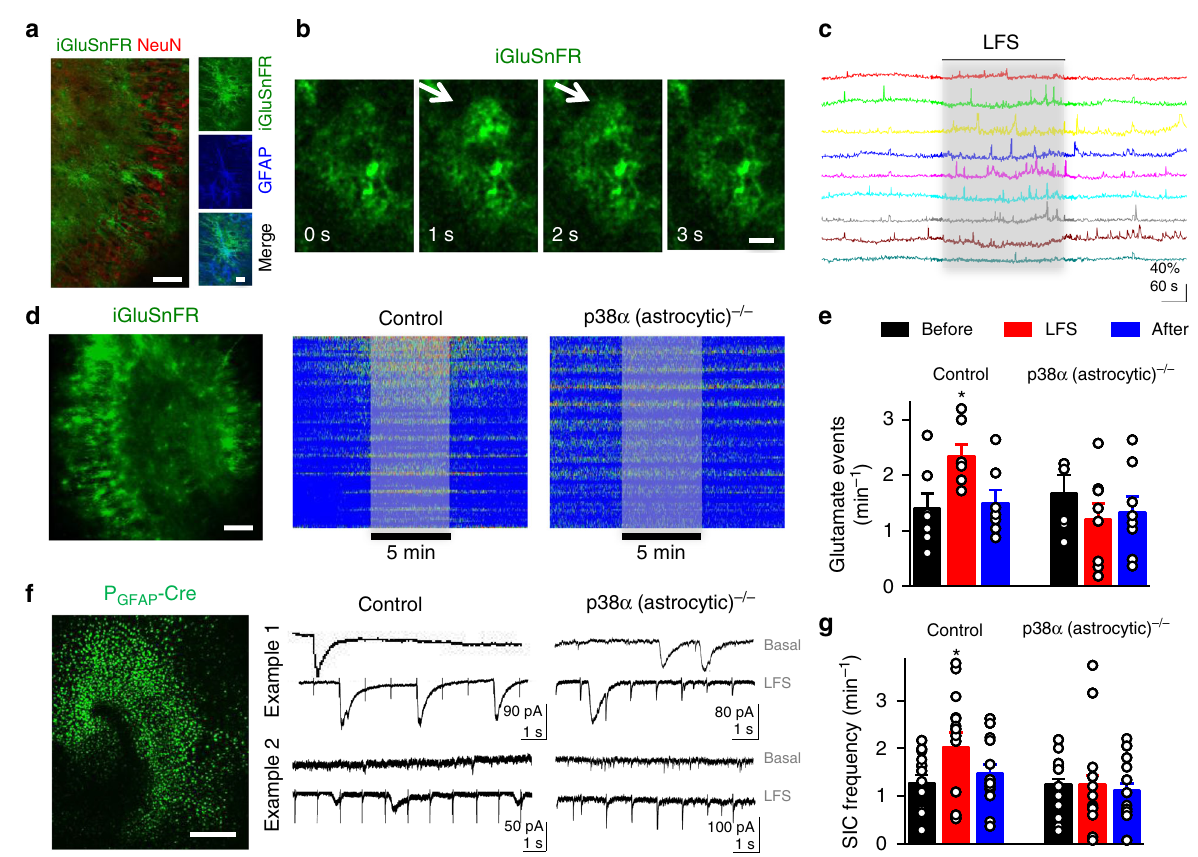
Fig. 8 Astrocytic p38 α is necessary for LFS-induced astrocyte-to-neuron communication. a Representative immunohistochemical localization of iGluSnFR, NeuN, and GFAP in organotypic hippocampal slices infected with AAV5- P GFAP -iGluSnFR. Right panels shown at higher magni fi cation. Scale bars, 50 µ m (left) and 30 µ m (right). b Representative two-photon images of iGluSnFR fl uorescence from individual astrocytes throughout time taken at 1 Hz. Arrows indicate a transient and local increase in glutamate-induced fl uorescence. Scale bar, 20 µ m. c Representative glutamate signals from the astrocytic surface before, during (gray beam) and after electrical LFS. Note the increased number of astrocyte iGluSnFR spikes during LFS. d Left, representative fl uorescence image showing an organotypic hippocampal slice expressing iGluSnFR under GFAP promoter. Scale bar, 300 µ m. Right, representative kymograph of glutamate activity (ROIs pooled from two different experiments were used), color-coded according to fl uorescence changes from p38 α lox/ + slices (left panel, Control) or from p38 α lox/lox slices (right panel, p38 α (astrocytic) − / − ) infected with P GFAP -Cre virus. The period of LFS is highlighted. e Quanti fi cation of frequency of glutamate events from images as the ones represented in d . Glutamate events in control and GFAP-Cre infected p38 α lox/lox slices were compared by Friedman test followed by Dunn's multiple comparison (* P < 0.05). Two-way repeated measures ANOVA demonstrated a signi fi cant interaction between AAV infection and the time of glutamate events. F (2;39) = 3.43, P = 0.04. Bonferroni post-hoc test: control vs. p38 α (astrocytic) − / − . Data are presented as means ± s.e.m. f Left, Confocal image of an organotypic hippocampal slice from p38 α lox/lox animals after 12 days viral transfection with AAV5- P GFAP -GFP-Cre. Scale bar, 300 µ m. Right, two examples of whole-cell currents from pyramidal neurons in p38 α lox/ + (left, Control) or p38 α lox/ lox (right, p38 α (astrocytic) − / − ) organotypic slices infected with P GFAP -Cre. g Frequency of SICs in basal conditions (before, black), during LFS (red) and after LFS (after, blue), binning of 5 min, quanti fi ed from recordings as the ones shown in f . SICs before, during and after LFS were compared by Friedman test followed by Dunns post-hoc test. Two way repeated measures ANOVA demonstrated a signi fi cant effect for AAV infection in SICs F (1;87) = 5.32; * P < 0.05. Bonferroni post-hoc test. Data are presented as means± s.e.m. For statistical details see Supplementary